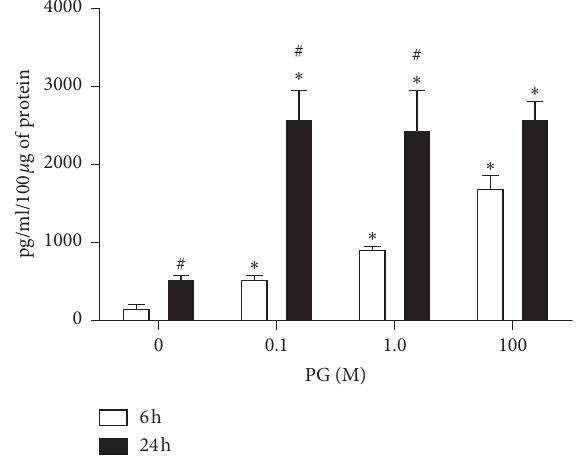
Figure 8: Hspa1a content in progesterone-treated RINm5F cells. Cells were incubated with 0.1, 1.0, or 100 μ M progesterone for 6 or 24h. Data are presented as means ± SEM of three experiments in duplicates. ∗ indicates difference in comparison to control. # in- dicates difference between 6 and 24h ( ρ < 0.05). PG: